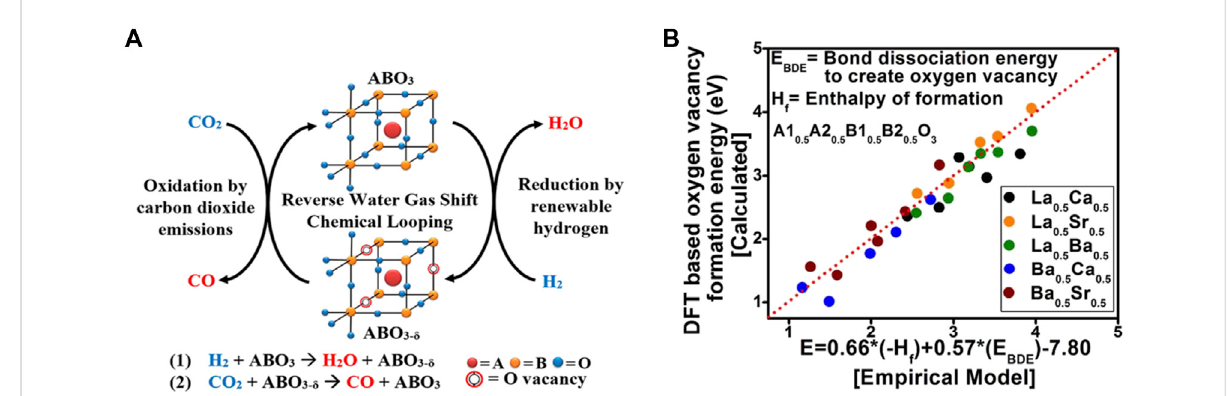
FIGURE 4 TheprocessofRWGS-CL (A) Reproducedfrom(Hareetal.,2018);Copyright © 2018(AmericanChemicalSociety)andtheempiricalmodelingof oxygen vacancy formation energies (Evac) of the perovskite oxides (B) Reproduced from Maiti et al. (2018); Copyright © 2018 (Royal Society of Chemistry).